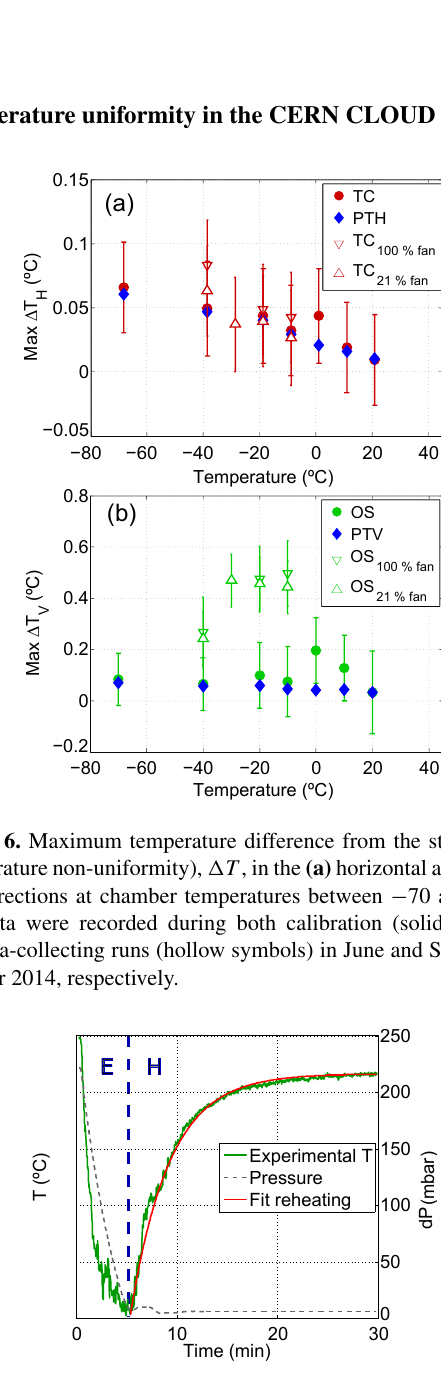
Figure 7. Example of an adiabatic pressure reduction to form a cloud in the CLOUD chamber. The chamber pressure is reduced from 220 to 5mbar above one atmosphere pressure during a period of 5min (dashed curve and right-hand scale). This produces of re- duction of the air temperature by around 5 ◦ C (green curve and left- hand scale, recorded by a TC sensor). Provided the initial relative humidity is sufficiently high, a liquid cloud forms in the chamber during the cool period. The air in the chamber then returns to its equilibrium temperature set by the relatively warm chamber walls, and the cloud eventually evaporates. In this example the initial air temperature, before expansion, had not yet reached the equilibrium value near 9.3 ◦ C. The red line is an exponential fit to the warming period with a time constant of 200s (Eq.